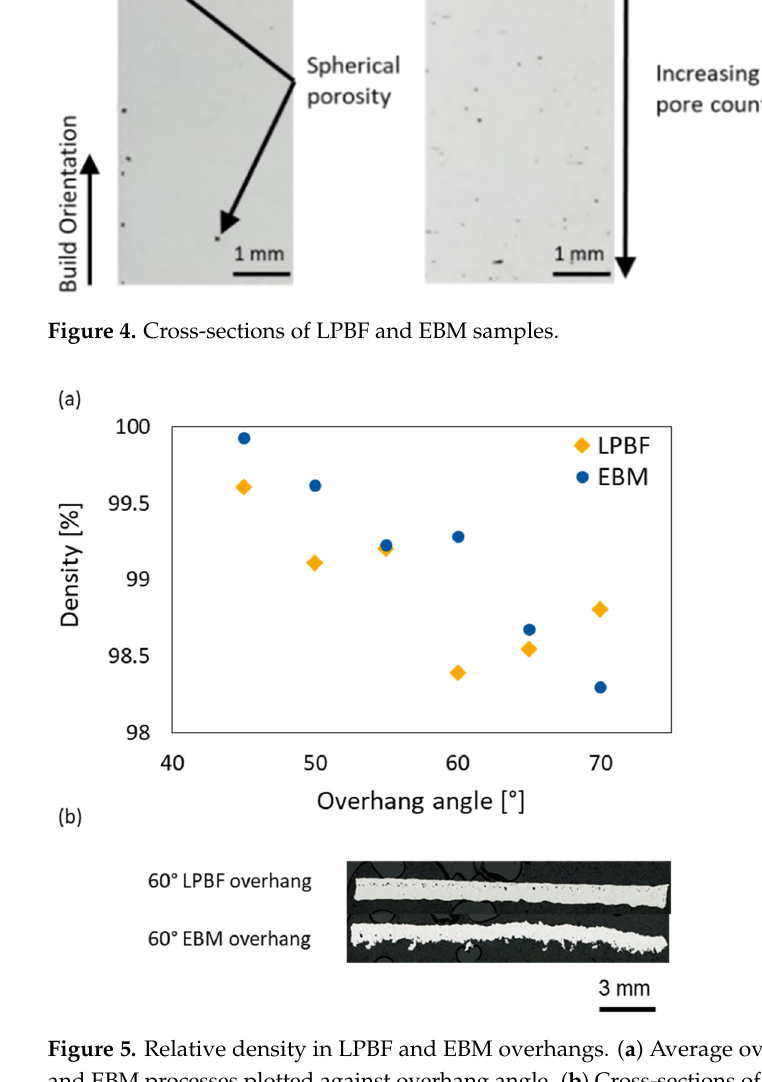
Figure 5. Relative density in LPBF and EBM overhangs. ( a ) Average overhang density from LPBF and EBM processes plotted against overhang angle. ( b ) Cross-sections of LPBF and EBM overhangs. The EBM overhangs are denser compared to those manufactured with LPBF. The density of EBM overhangs decreases linearly with an increasing overhang angle. Pores form mostly on the lower side of the EBM overhang.